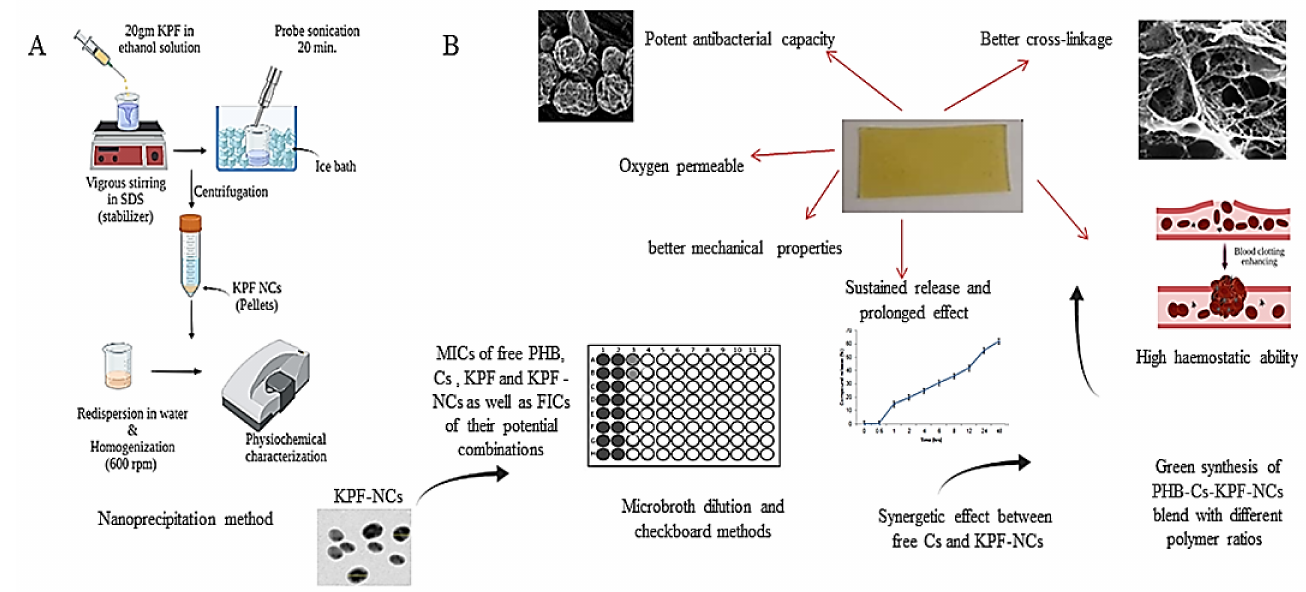
Figure 2. Nanoprecipitation method for KPF-NCs preparation ( A ) and PHB-Cs-KPF-NCs blend with different capacities ( B